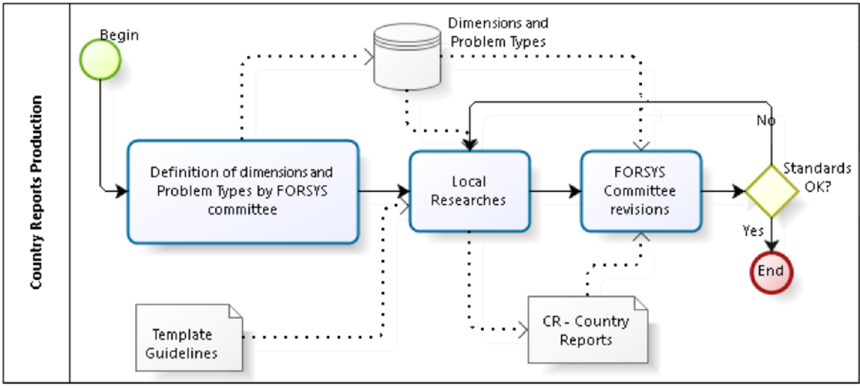
Figure 1. Country Reports Production Process.